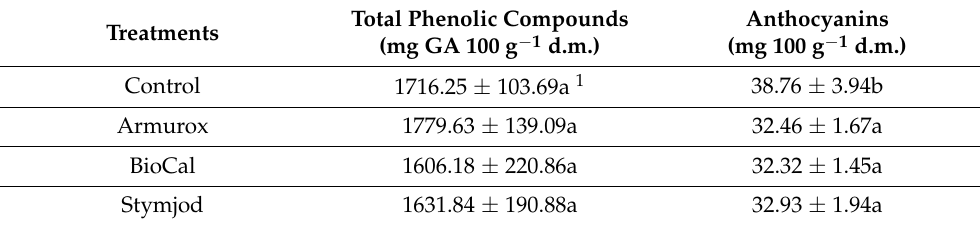
Table 10. Effect of foliar fertilization on the content of health-promoting compounds in blueberry fruit in